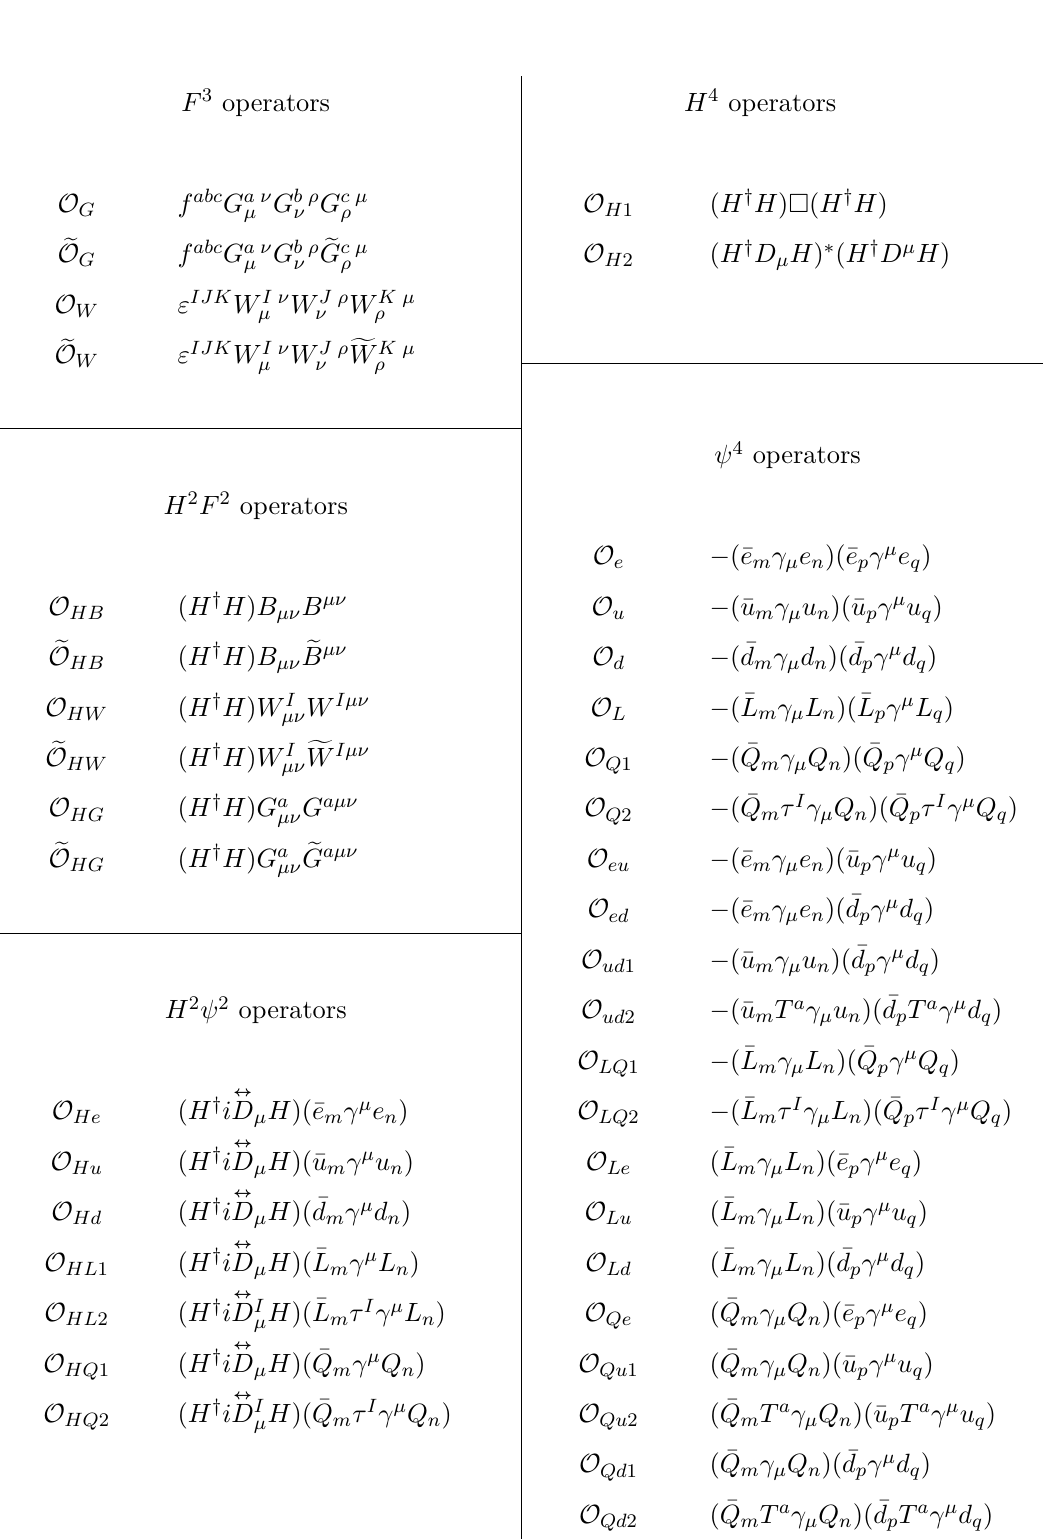
Table 1 . The subset of operators in the dimension-six SMEFT [1] considered in this work: those containing quartic interactions allowing for two-to-two elastic scattering of eigenstates of spin and the SM gauge